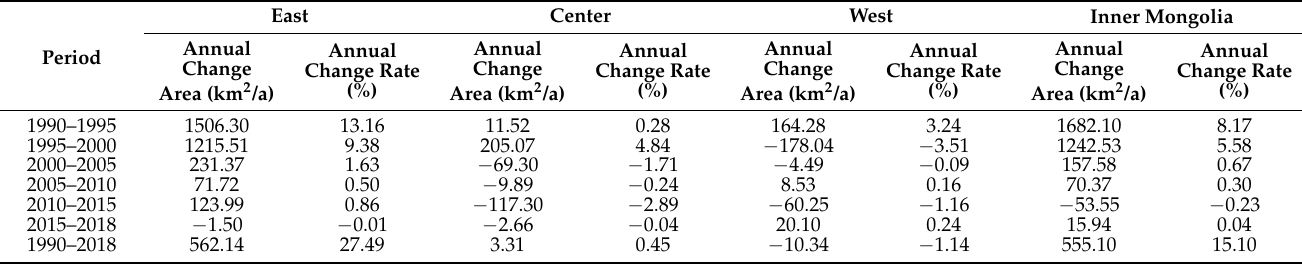
Table 1. Cropland changes in different sub-regions during different